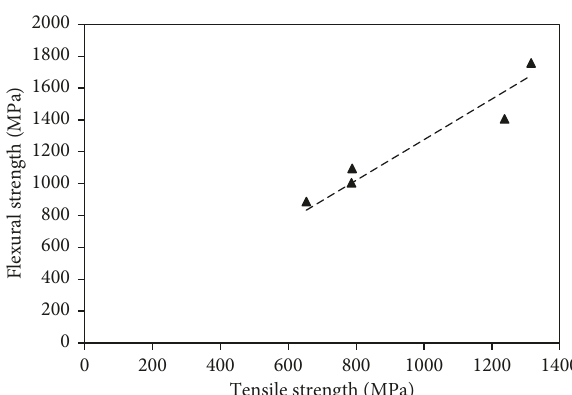
Figure 3: Relationship between tensile modulus and strength of GFRP bars. Figure 4: Correlation between flexural and tensile strength of GFRP